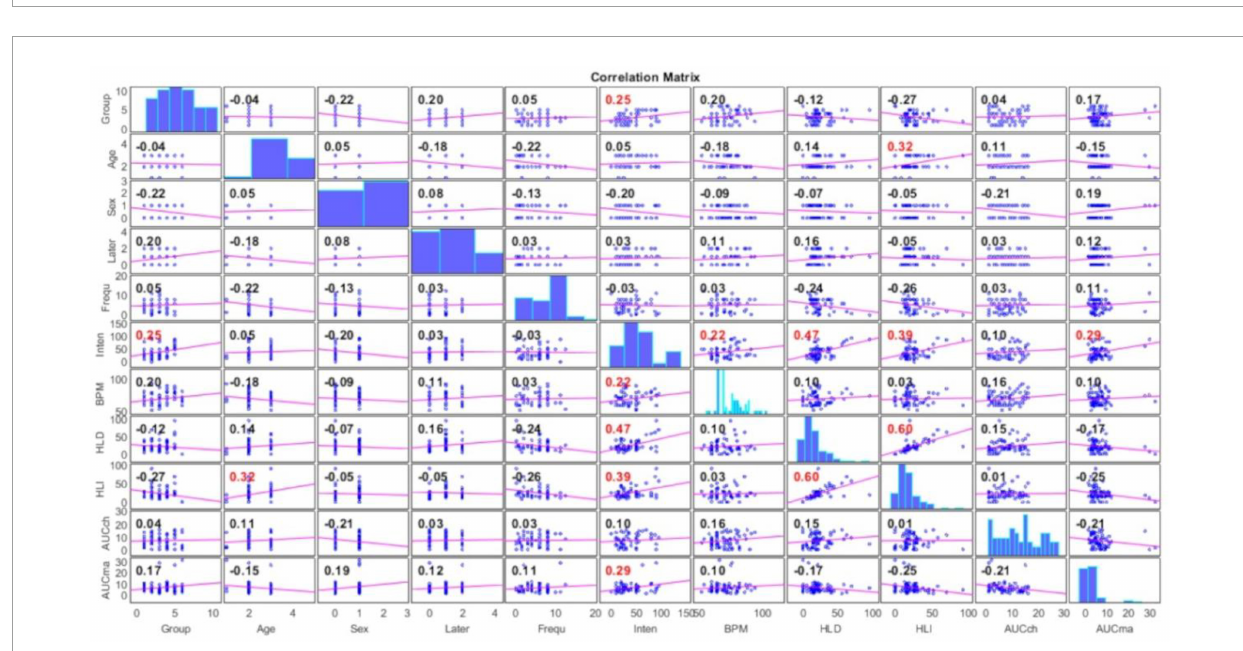
FIGURE14 Correlation between demographic (age, sex) and audiological [tinnitus laterality, tinnitus frequency, tinnitus intensity, and hearing loss (both left and right)] information with magnitude (AUCmax) and topographical distribution (AUCch) of AERPs. Significant correlations are in red color.